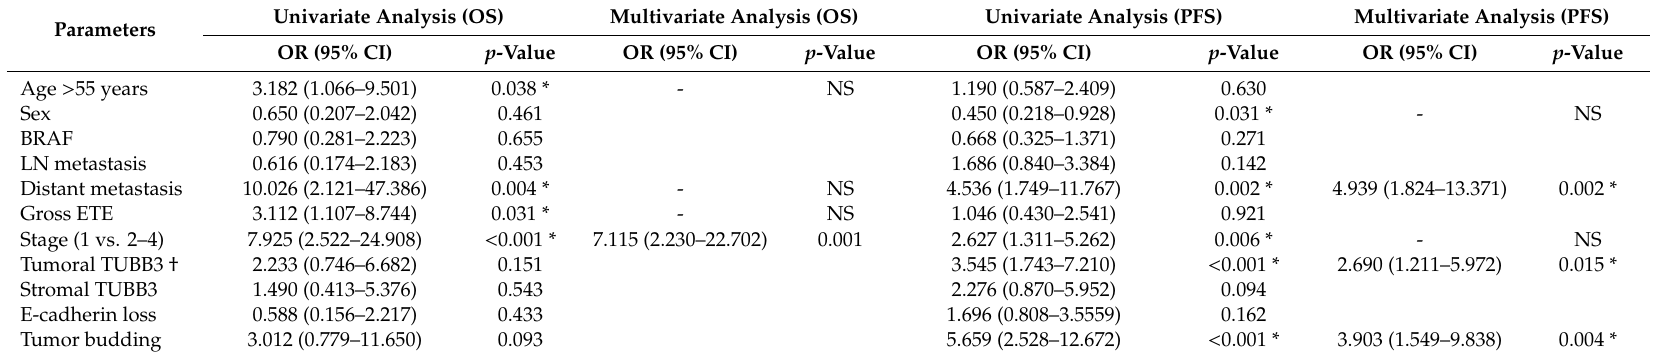
Table 3. Survival analysis in conventional papillary thyroid